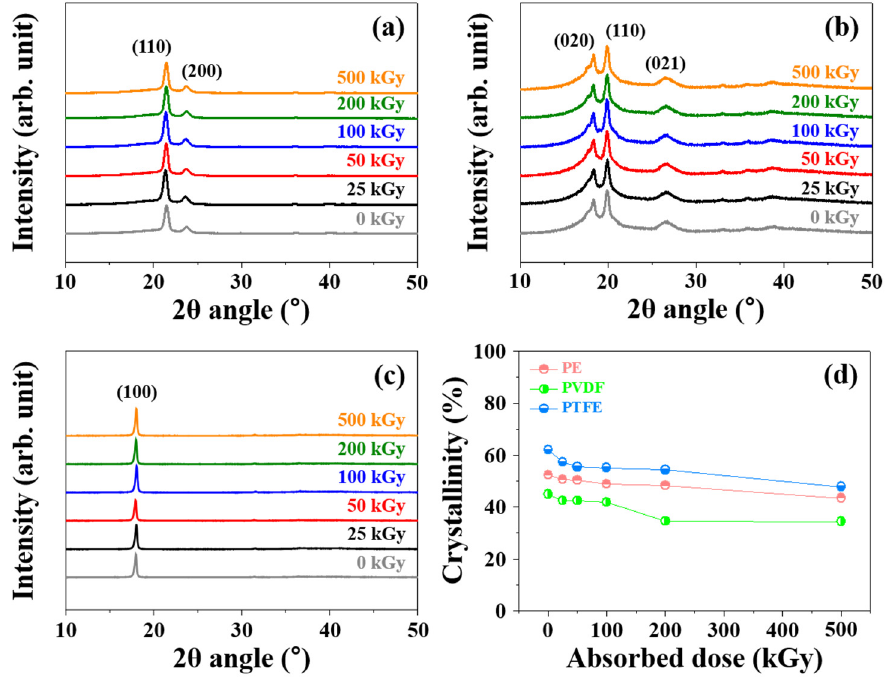
Figure 4. XRD patterns of ( a ) PE, ( b ) PVDF, and ( c ) PTFE; ( d ) Changes in the crystallinity of PE, PVDF, and PTFE.